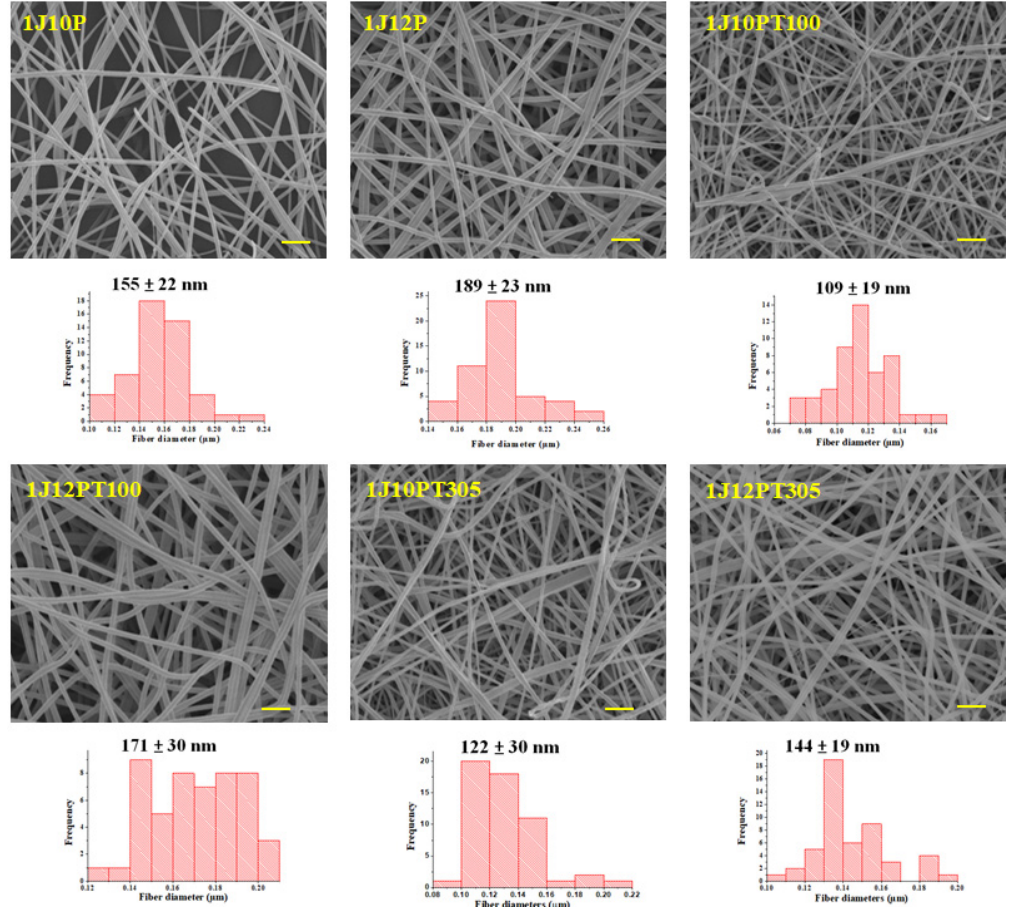
Figure 4. SEM micrographs showing the morphology and diameter distributions of 1% JFP/pullulan (10–12%) nanofibers along with surfactants (Triton X ‐ 100 and Triton X ‐ 305). Scale bar 1 μ m; 10,000×.